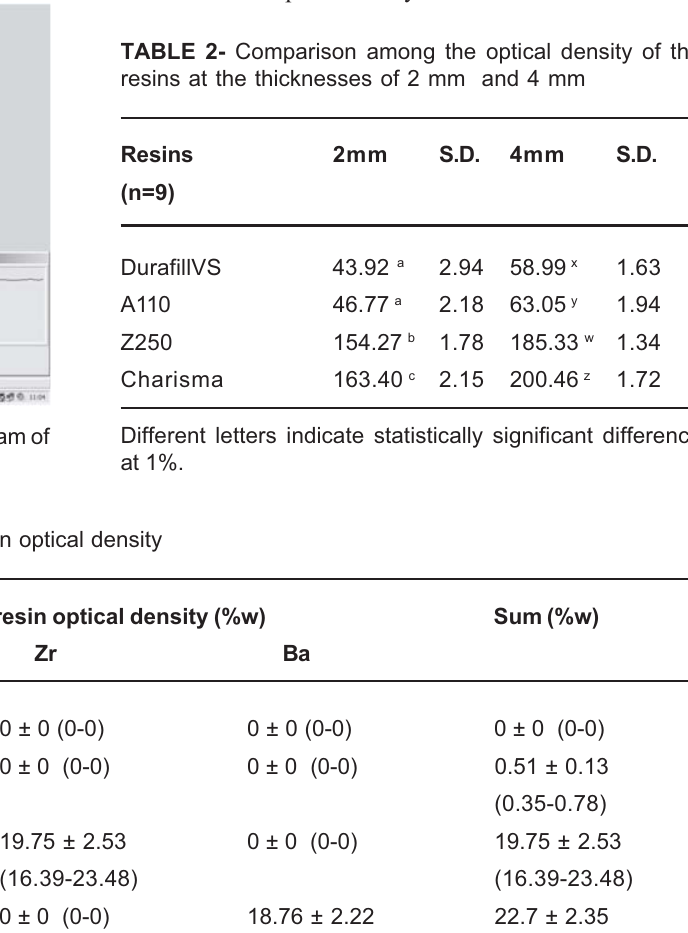
* a=mean values, b= standard deviation, c= minimum and maximal values.